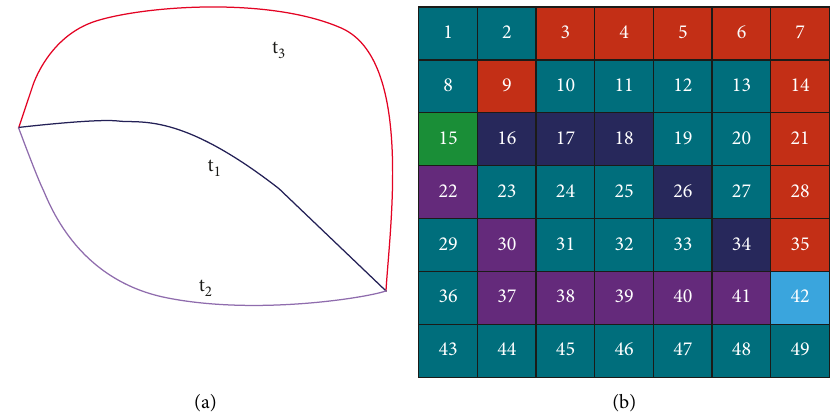
Figure 3: An illustration of grid mapping. t